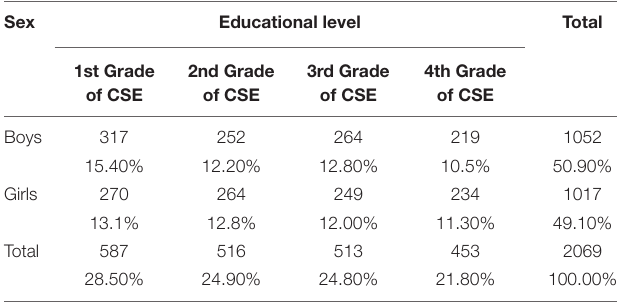
TABLE 1 | Distribution of the sample by sex and educational